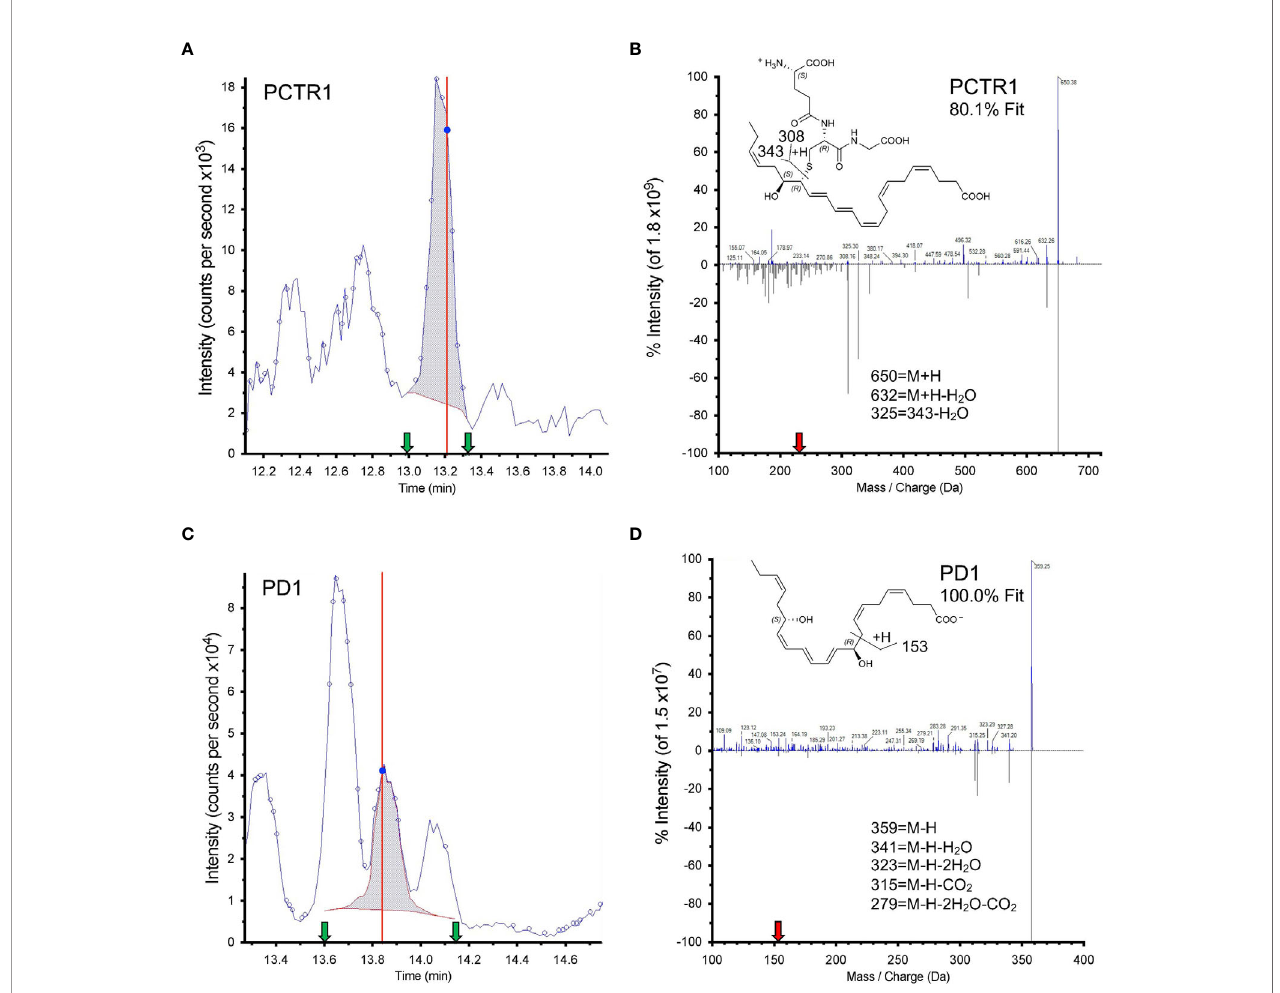
FIGURE 6 | Identi fi cation of PCTR1 and PD1 from RSV-infected mouse lung. (A, C) Screen captures from Sciex software of (A) PCTR1 and (C) PD1 targeted multiple reaction monitoring (MRM). Dark blue data-point indicates where the spectra for (B, D) were collected; vertical red line indicates the retention time for that data point. Shaded blue area denotes the area under the curve used for quantitation. Green arrows denote retention time at start and fi nish of quantitation. (B, D) Structure and tandem mass spectrometry fragmentation for (B) PCTR1 ( m/z 650>231) with 80.1% unbiased fi t to library and matching retention time and (D) PD1 ( m/z 359>153) with 100% unbiased fi t to library and matching retention time, analyzed with Sciex software. Upper MS/MS denotes sample spectrum; mirrored lower MS/MS denotes library spectrum obtained for synthetic PCTR1 and PD1. The red arrow on the x axis indicates Q3 used for quantitation. Insets show structures and proposed ion